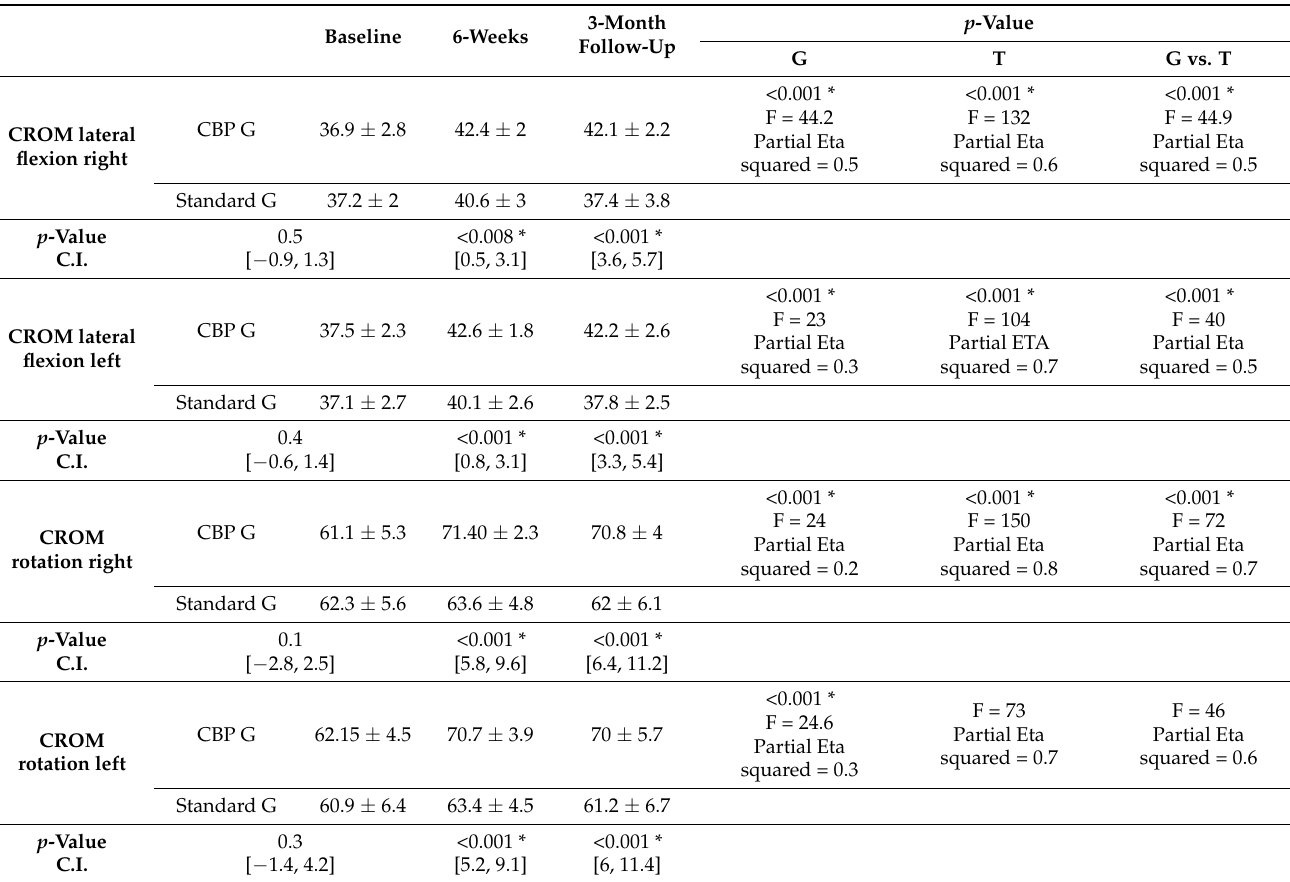
Table 4. The changes in ROM outcomes in both groups vs. time. The values are mean ± standard deviation. CBP = CBP group; standard: standard exercise group; G = group, T= time, C.I. [] = 95% confidence interval, p -Value = statistical significance; * = statistically significant